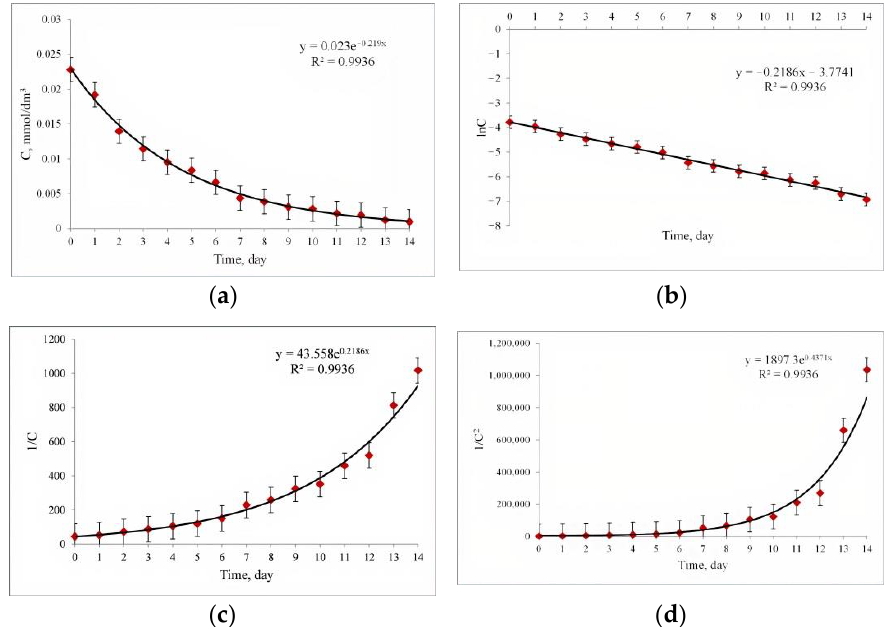
Figure 5. Kinetic curves of the CAPB biodegradation process by the strain Pseudomonas pseudoalcaligenes (B-6783) VSB-10 in four coordinate systems: ( a ) the coordinate system for the 0th order reaction; ( b ) the coordinate system for the 1st order reaction; ( c ) the coordinate system for the 2nd order reaction; ( d ) the coordinate system for the 3rd order reaction.